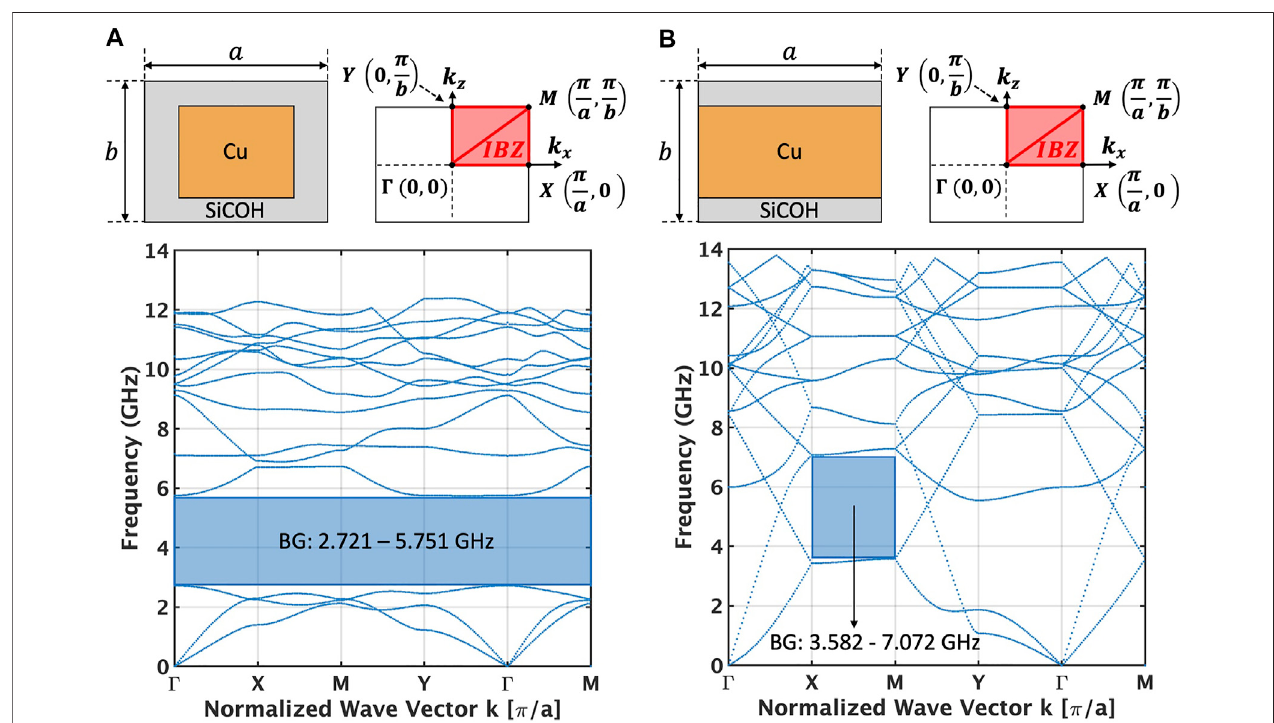
FIGURE 3 | (A) Acoustic bandstructure for a BEOL PnC unit cell implemented in the IBM12RF SOI process exhibiting a complete band-gap. (B) Acoustic bandstructure for a BEOL re fl ector plate unit cell implemented in the IBM12RF SOI process exhibiting a partial band-gap along the X-M direction only.